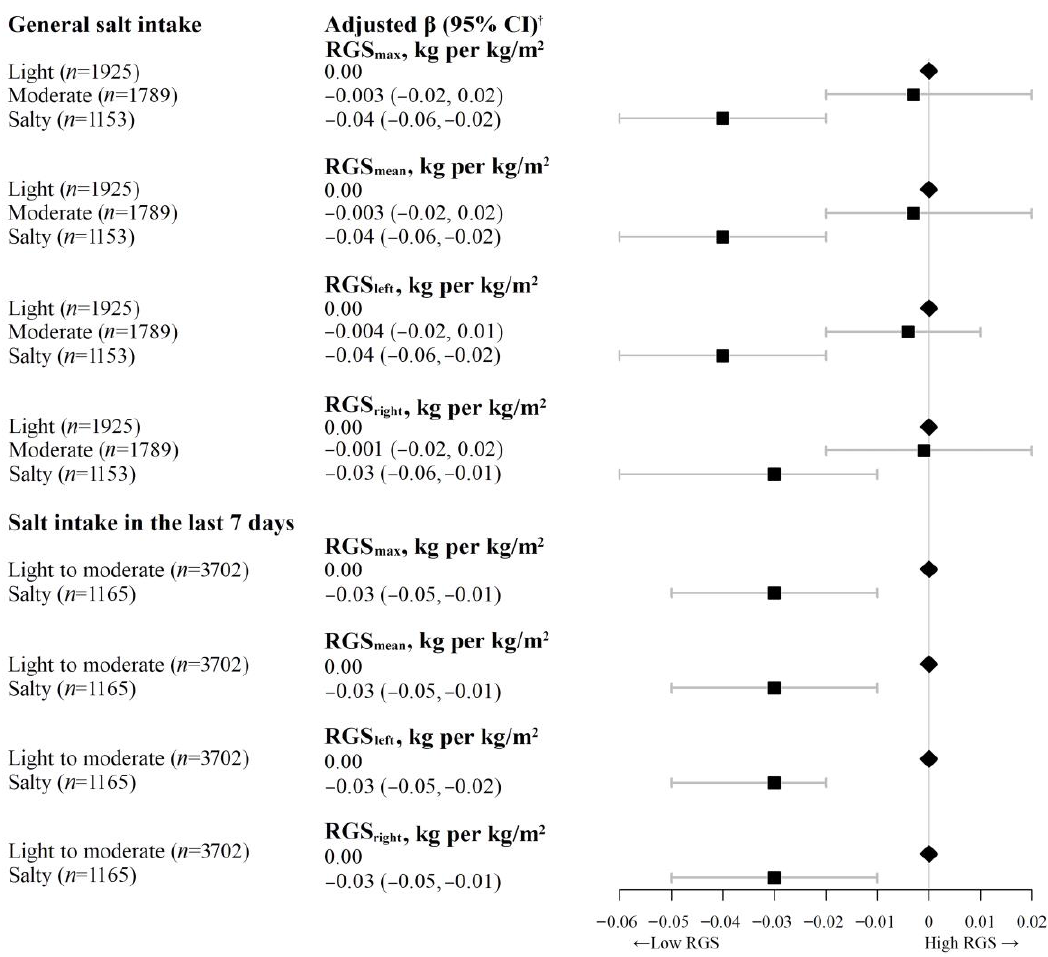
Figure 1. Association of salt intake with relative grip strength (kg per kg/m 2 ) on 4867 participants of the Guangzhou Biobank Cohort Study. CI = confidence interval, RGS max = maximum of the right or left relative grip strength, RGS mean = average of the right and left relative grip strength, RGS left = the left relative grip strength, RGS right = the right relative grip strength. † Adjusted β (95% CI): adjusted for sex, age, education, family income, occupation, physical activity, smoking status, alcohol use, self-rated health, and self-reported hypertension.